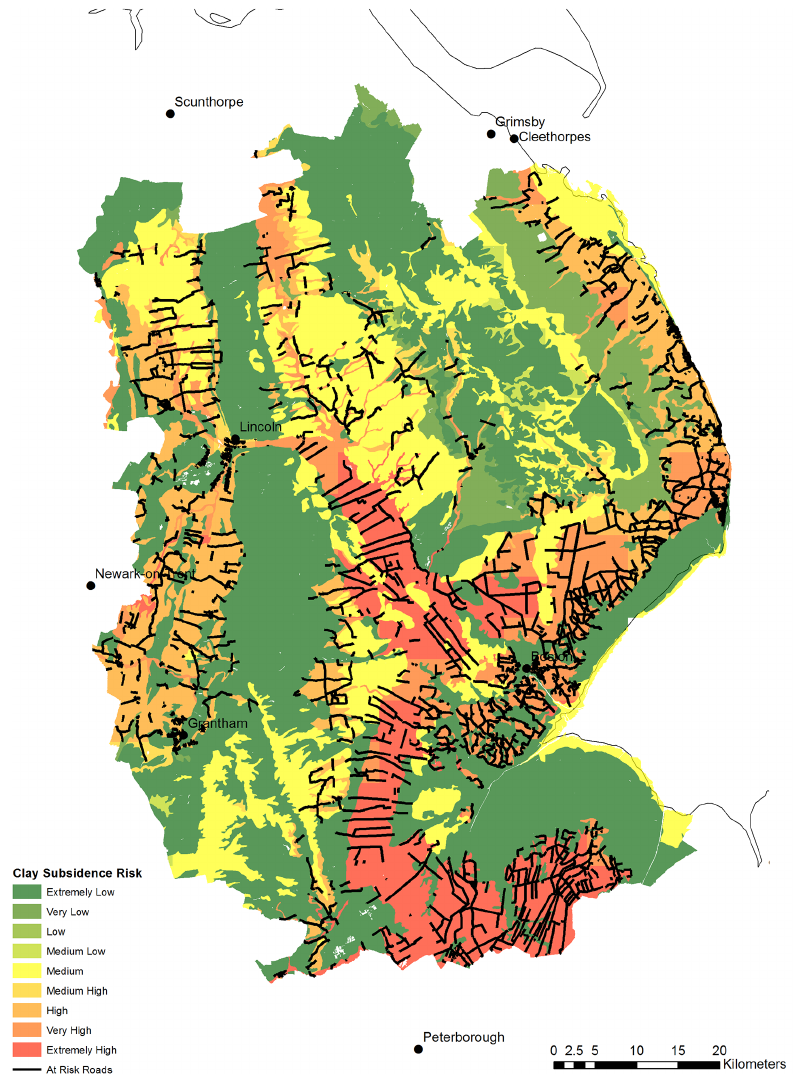
Figure 6. Road sections identified “at risk” of clay-related subsidence at present (soils data (England and Wales) © Cranfield University and for the controller of HMSO